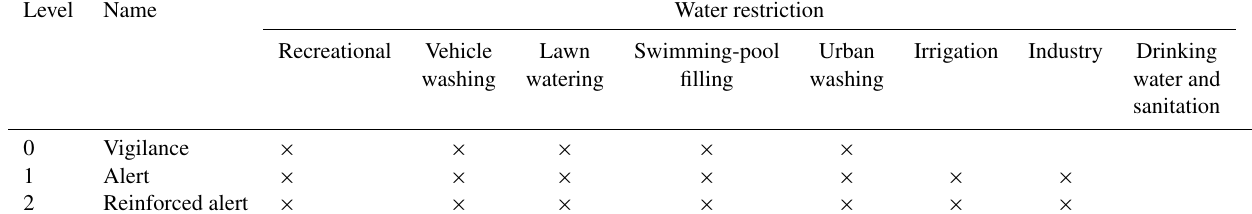
Table 3. Uses affected by water restriction according to the drought severity.